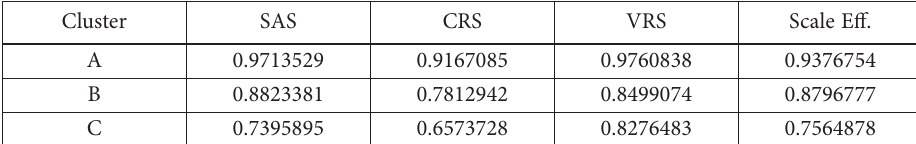
Table 3. Cross-period comparison between clusters (source: compiled by the author) Cluster SAS CRS VRS Scale